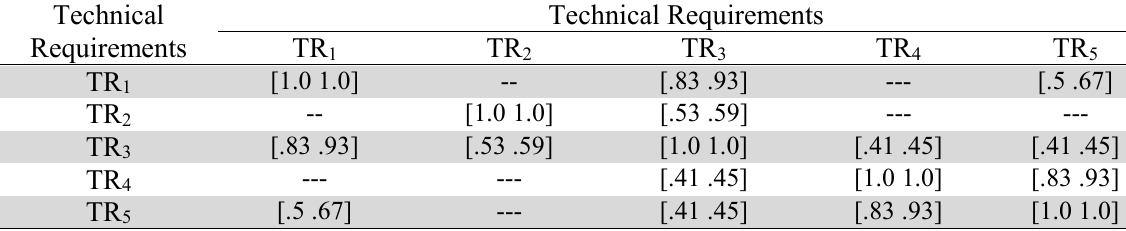
Table 3 TR correlation values(r jl ) Technical Requirements